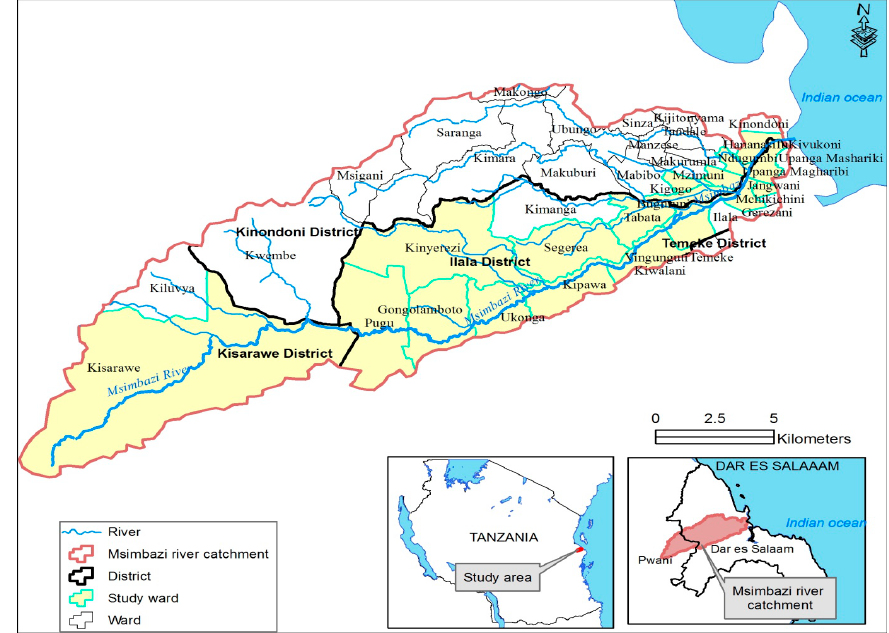
Figure 2. Map of the Msimbazi River catchment showing the study location. The study was carried out in 22 wards (indicated in yellow) located in Kisarawe, Ilala and Kinondoni districts. These included Pugu station, Gongolamboto, Ukonga, Kipawa, Segerea, Tabata, Vingunguti,